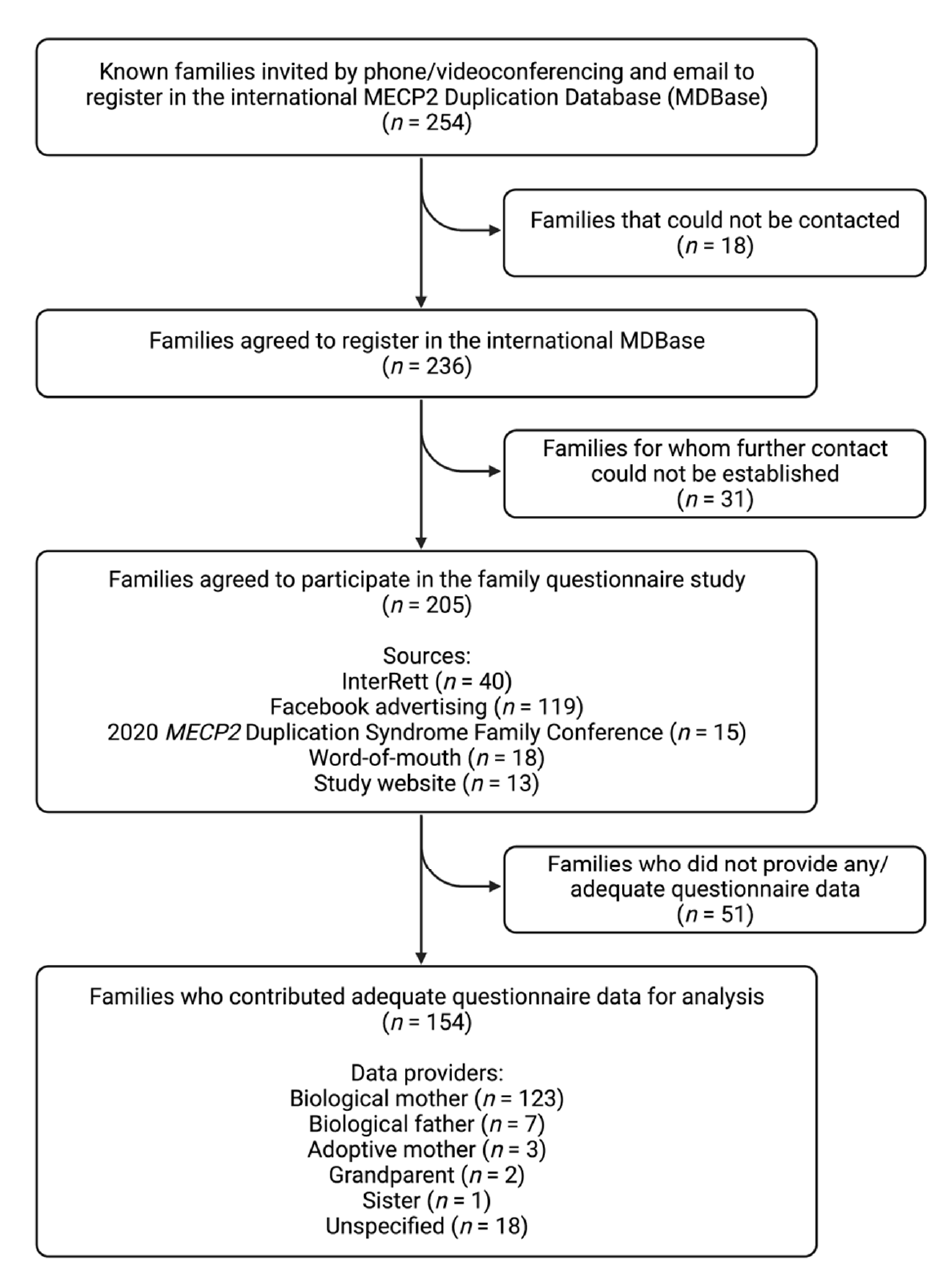
Figure 4. Study flow chart of case ascertainment and data collection for the international MECP2 Duplication Database (MDBase).